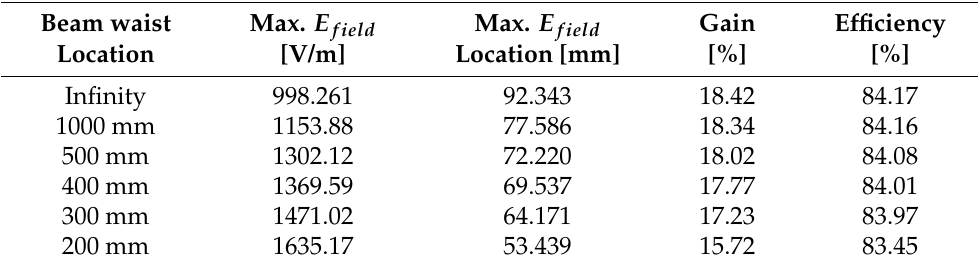
Table 2. Details of the radiation produced by varying the electric current distribution feeding the phased array.